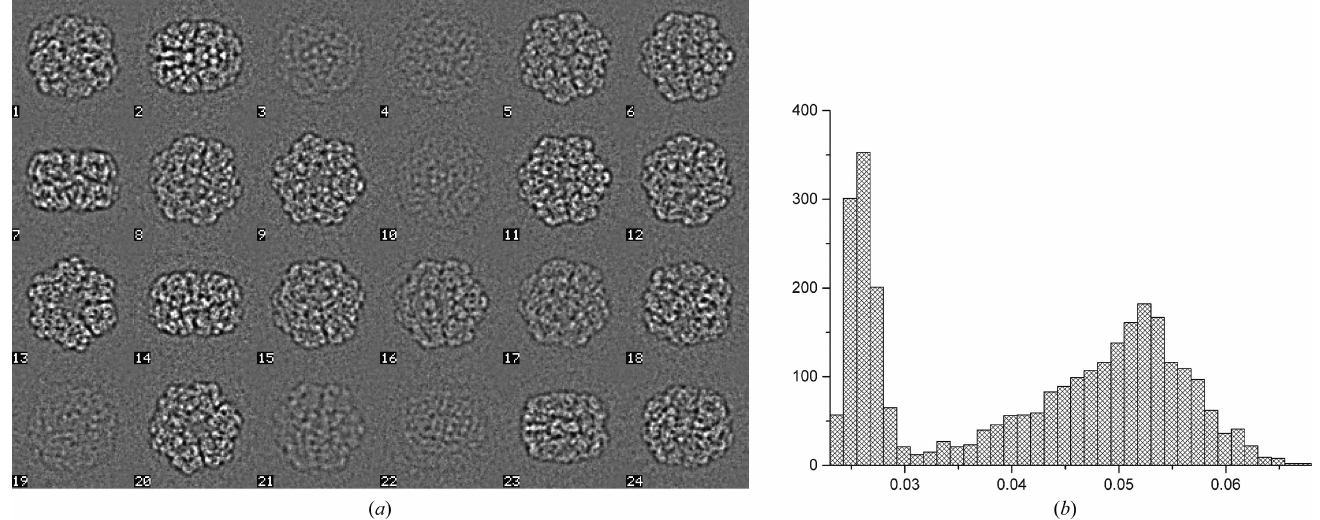
Figure 9 ( a ) Class averages randomly extracted from the total of 3000. High-contrast class averages are associated with good views of the worm haemoglobin, whereas low-contrast class averages are associated with atypical false-positive particle detections. ( b ) The histogram of standard deviations of 3000 class averages (205 764 particles) reveals a bimodal distribution in which virtually all remaining false positives land in low-contrast class